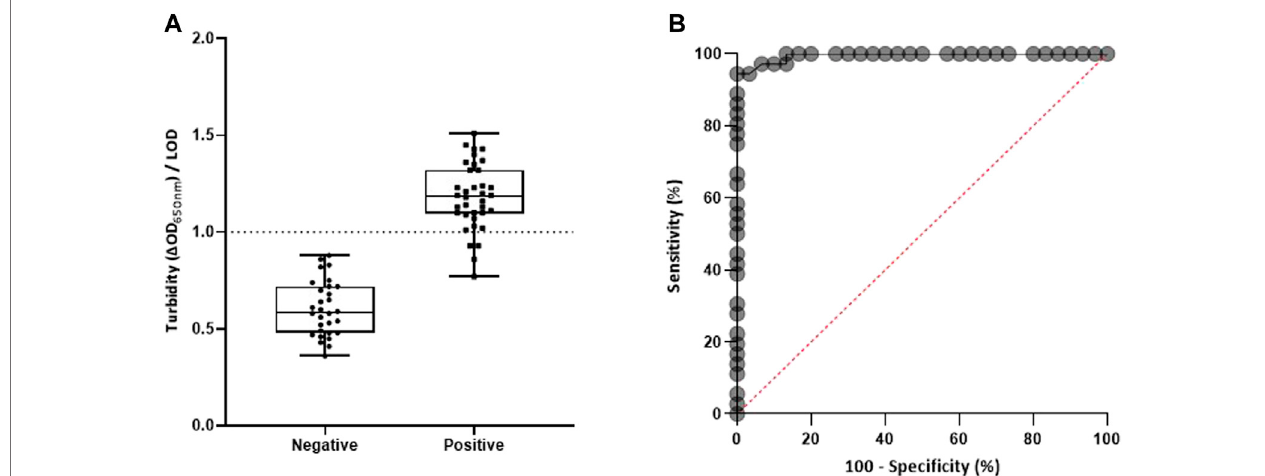
FIGURE3| Molecular MFEAreadoutfor DENV RNA − and DENV RNA + plasma samples. (A) DENVRNA − samples ( n (cid:1) 30) and DENV RNA + samples( n (cid:1) 37) were evaluated. The difference in optical density at 650 nm ( Δ OD 650nm ) measured prior to and following three magnetization cycles was used to express the turbidity signal. The LOD (limit of detection) is the mean value of blank samples plus three standard deviations. Individual points on the scatterplot are the turbidity/LOD signal ratio calculated by the molecular MFEA readout for a sample. Data are expressed as median ratios with interquartile ranges. p value < 0.0001; unpaired t -test. (B) Receiver operating characteristic (ROC) curve. The ROC curve is generated by plotting true-positive fractions (sensitivity %) (true-positive samples/true-positive plus false-negative samples) versus false-positive fractions (100 − speci fi city %) (false-positive samples/false-positive plus true-negative samples). AUC, area under the ROC curve.